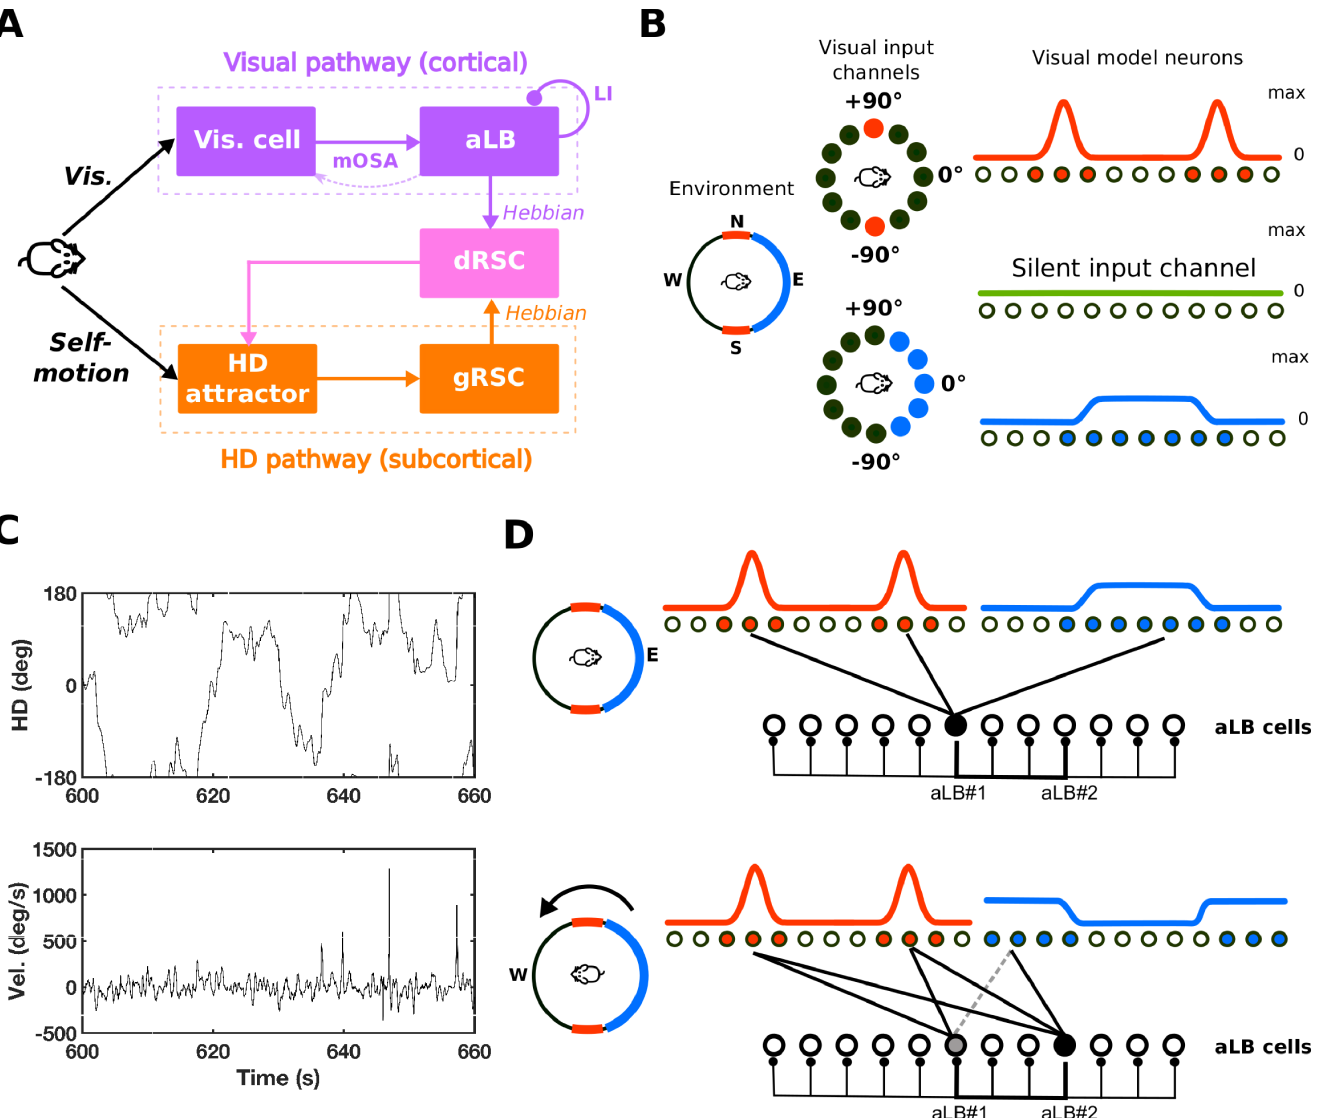
Fig 1. The basic structure of the HD system with two-stage visual landmark processing. (A) The systems-level network structure of the HD system which contains two pathways, processing visual landmarks (purple) and HD self-motion inputs (orange) respectively. The two pathways meet in dRSC (pink) where the integrated signal is generated and projected back to the HD attractor in order to correct for drift and keep a global real-time sense of direction. (B) Visual layers consisting of neurons tuned to specific features at specific egocentric directions. Different colors (red, blue, and green) stand for different features. Left: a circular environment; N, E, S, and W represent the allocentric directional frame. Middle: numerical degrees represent the egocentric directional frame (with 0 indicating ahead), here shown for the red and blue feature sensitive neurons. Right: Firing-rate responses across populations of feature-specific neurons. (C) The agent’s HD in simulation is taken from data-foraging rat. Top: Allocentric trajectory at the 11th minute of a 20-minute trajectory. Bottom: The corresponding angular velocity at the 11th minute. (D) The unimodal encoding of aLB cells when the agent is facing east (top) and then west (bottom). Two different aLB cells encode sceneries from different facing directions despite a large overlap in perceptual features (red cues). Darker filled circles indicate stronger activation of aLB cells, whilst darker lines indicate stronger feed-forward connections and inhibitory connections among aLB cells. The dashed line (bottom) indicates an example of a connection that has been depressed when the agent was facing East, so that the updated position of the cue in the visual field will not drive a previously active aLB neuron. Abbreviations: HD: head-direction(al); aLB: abstract landmark bearing; dRSC/gRSC: dysgranular/granular retrosplenial cortex; Vis.: visual; mOSA: modified Oja’s Subspace Algorithm; LI: lateral self-inhibition; Vel.: (angular)